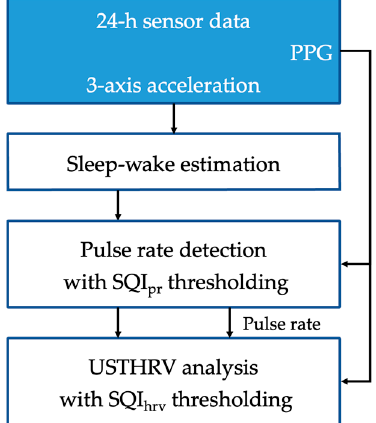
Figure 1. The 24 h heart rate variability analysis framework.